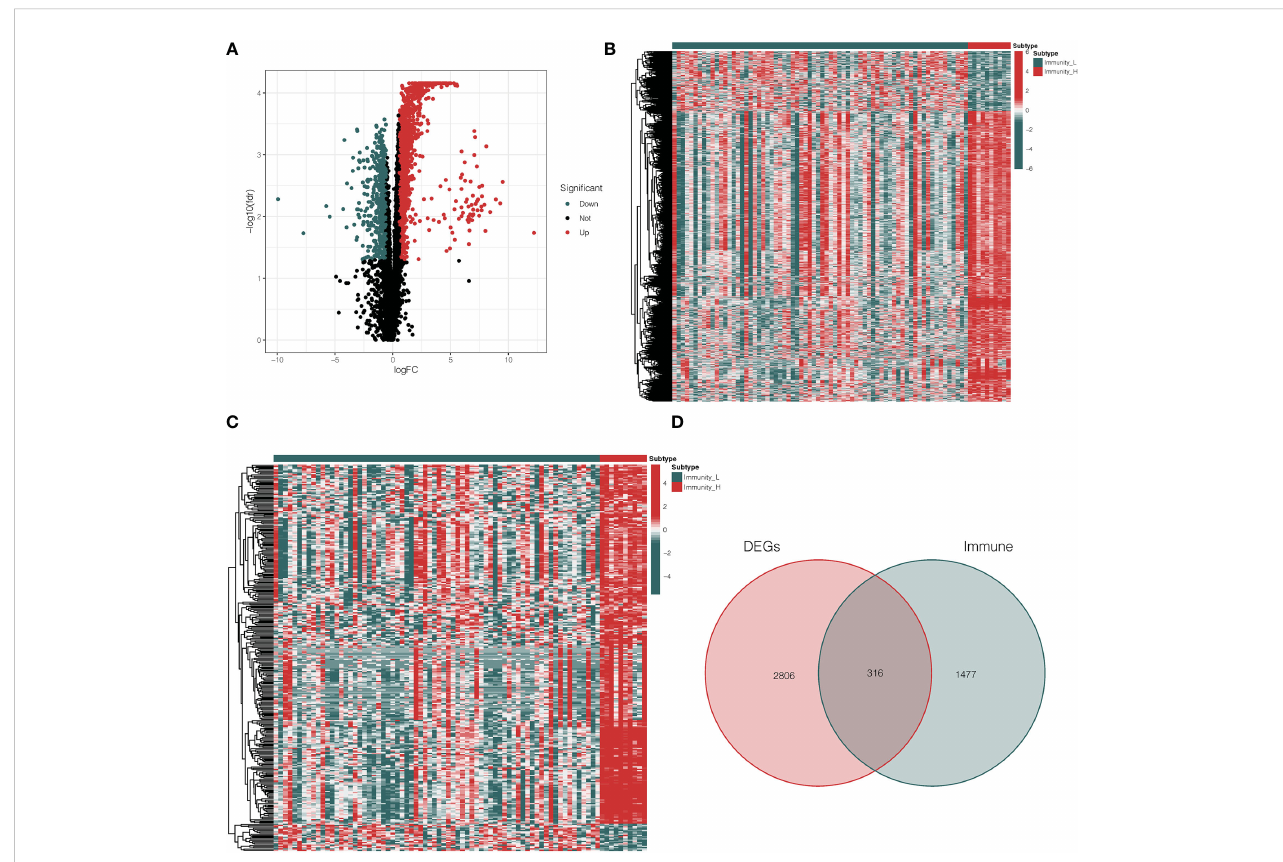
FIGURE 2 Analysis of differentially expressed immune-related genes. (A) The volcano plot showed that 2588 up-regulated genes and 534 down-regulated genes between Immunity_H and Immunity_L clusters. The red and blue bars stand for up-regulated genes and down-regulated genes, respectively. (B) The heatmap showed the expression level of DEGs in the Immunity_H and Immunity_L clusters. (C) The heatmap showed the expression level of immune- related genes in the Immunity_H and Immunity_L clusters. (D) The Venn diagram identi fi ed 316 genes from both gene sets. DEGs differentially expressed